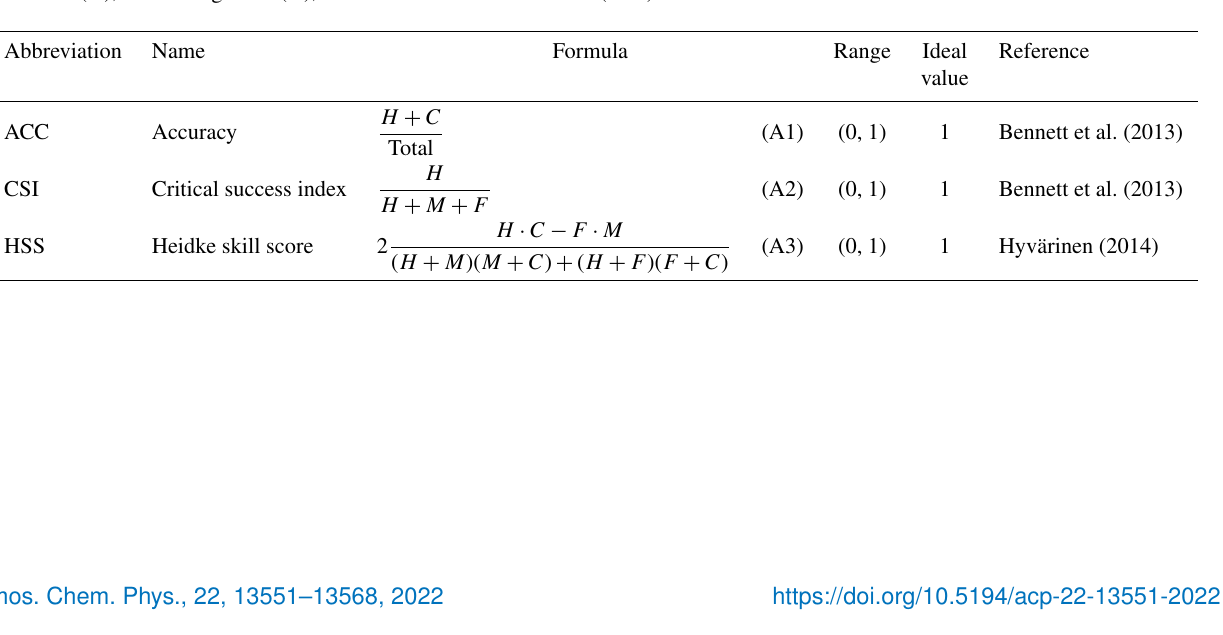
Table A1. Details of scores that compare observed versus predicted events. The scores are calculated with the help of hits ( H ), misses ( M ), false alarms ( F ), correct negatives ( C ), and the total number of events (total).